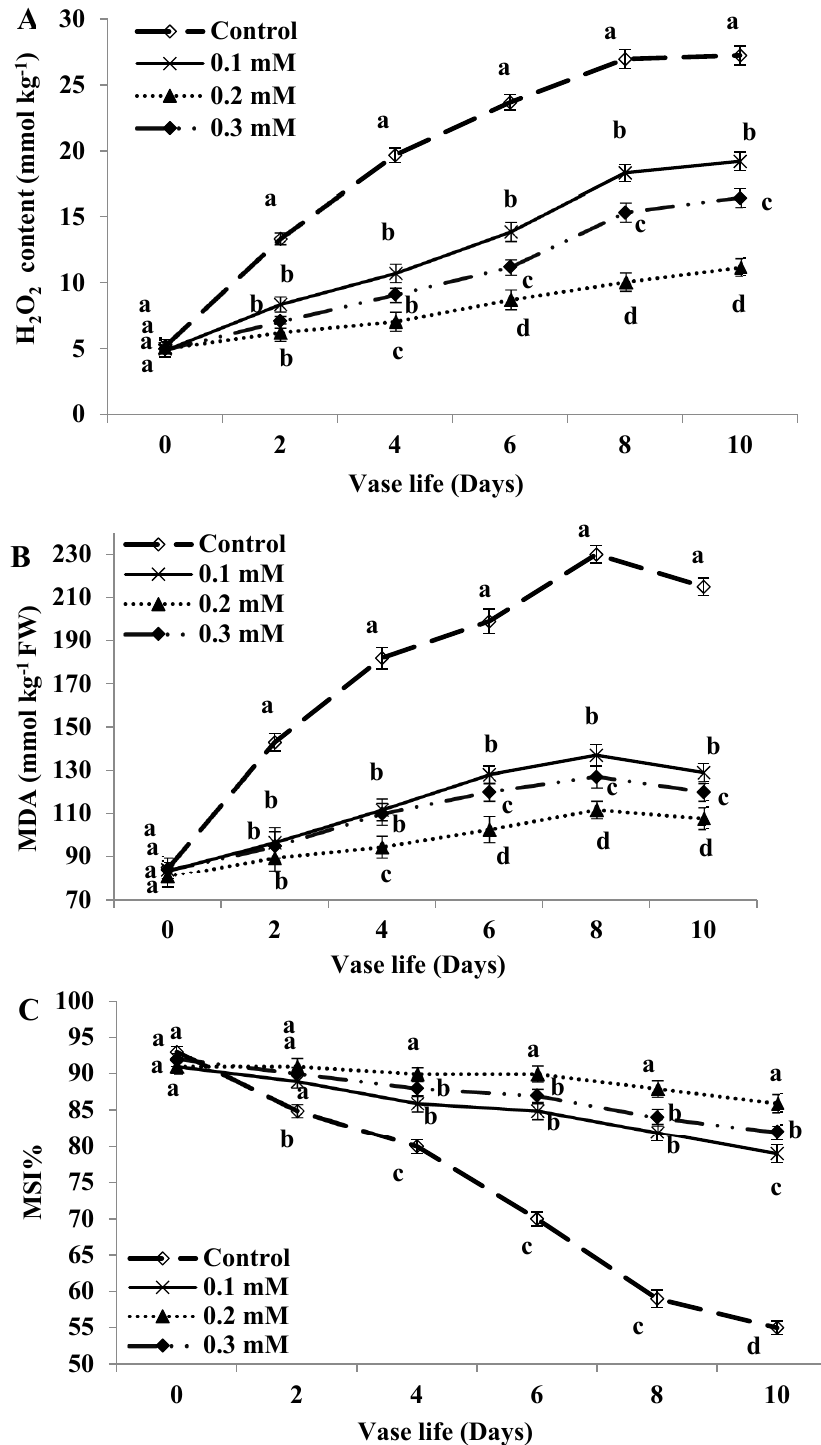
Figure 5. H 2 O 2 production ( A ) Malondialdehyde content ( B ), and membrane stability index ( C ) of cut roses treated with melatonin at 0.1, 0.2 and 0.3 mM. Each value is the mean ± SE of two experiments. Values that have different letters are significantly different based on Tukey-Kramer’s multiple range test at p ≤ 0.05.